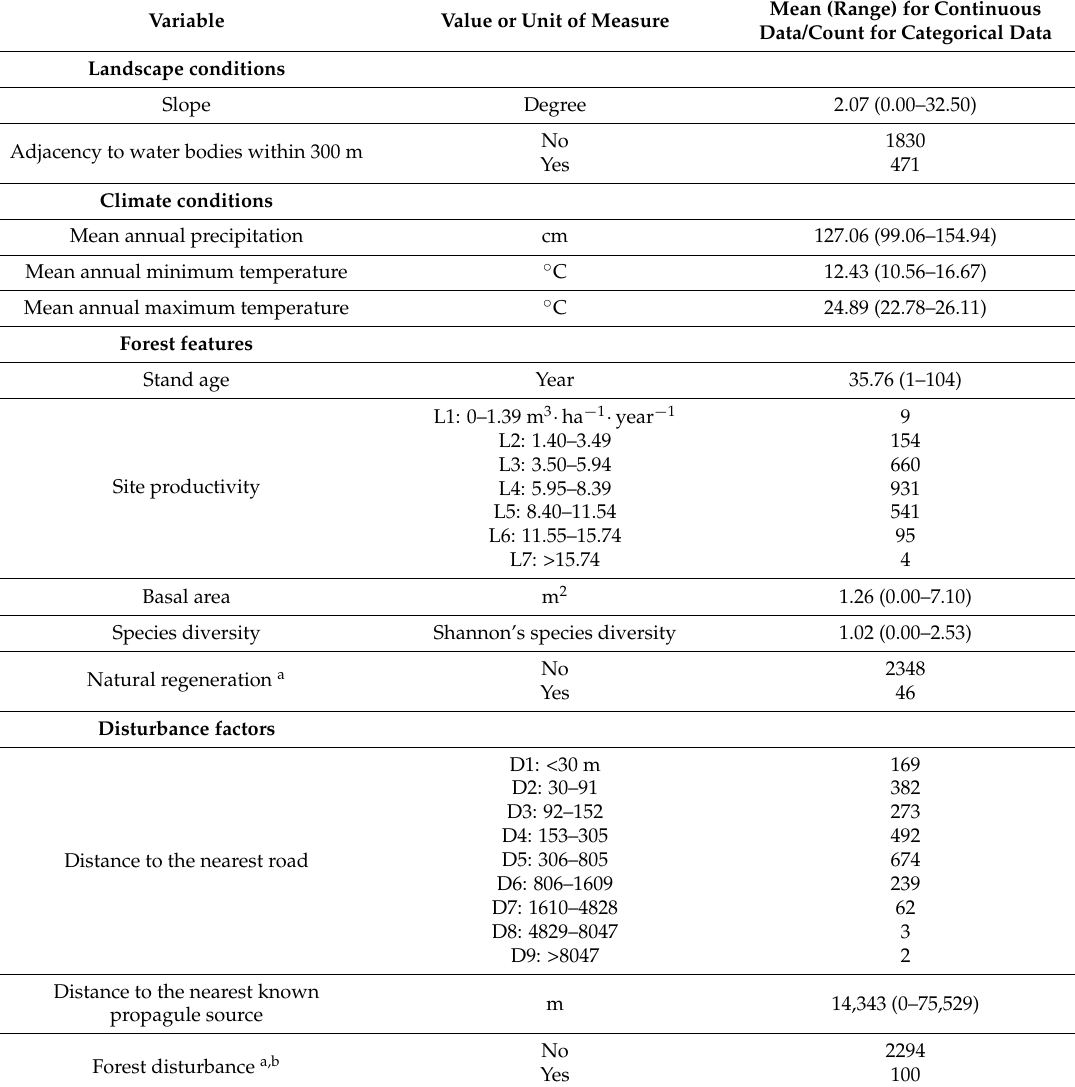
Table 1. Descriptions, possible values or units of measure, and means or counts of landscape conditions, forest features, disturbance factors, and forest management activities evaluated as potential factors of site invasion by Japanese honeysuckle in forest plots of eastern Texas. Mean (Range) for Continuous Value or Unit of Measure Data/Count for Categorical